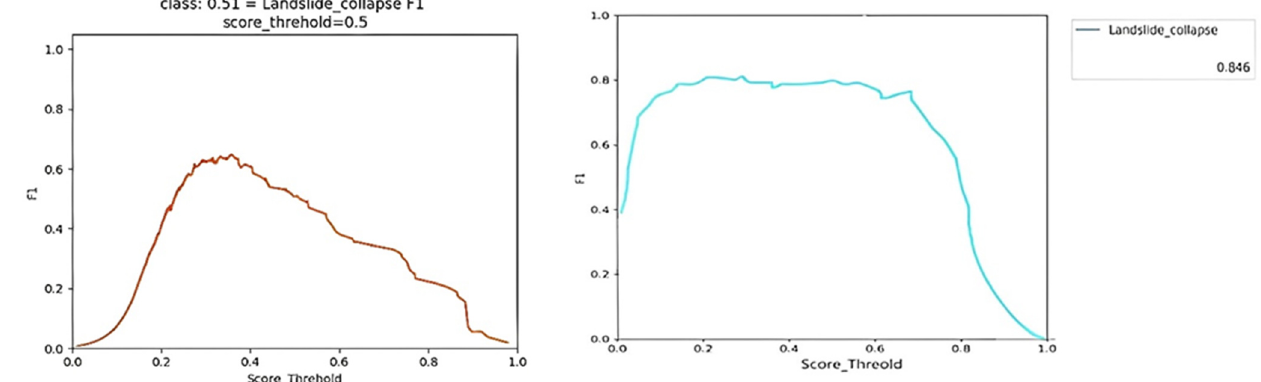
Figure 14. The F1 score of the SSD model ( left ) and the transfer learning model ( right ).